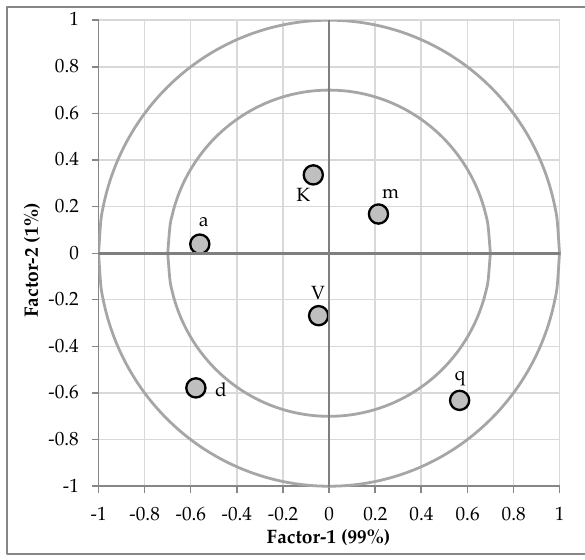
Figure 9. Monte Carlo – based sensitivity analysis; extremes drawn in black from DoE (Figure 8).